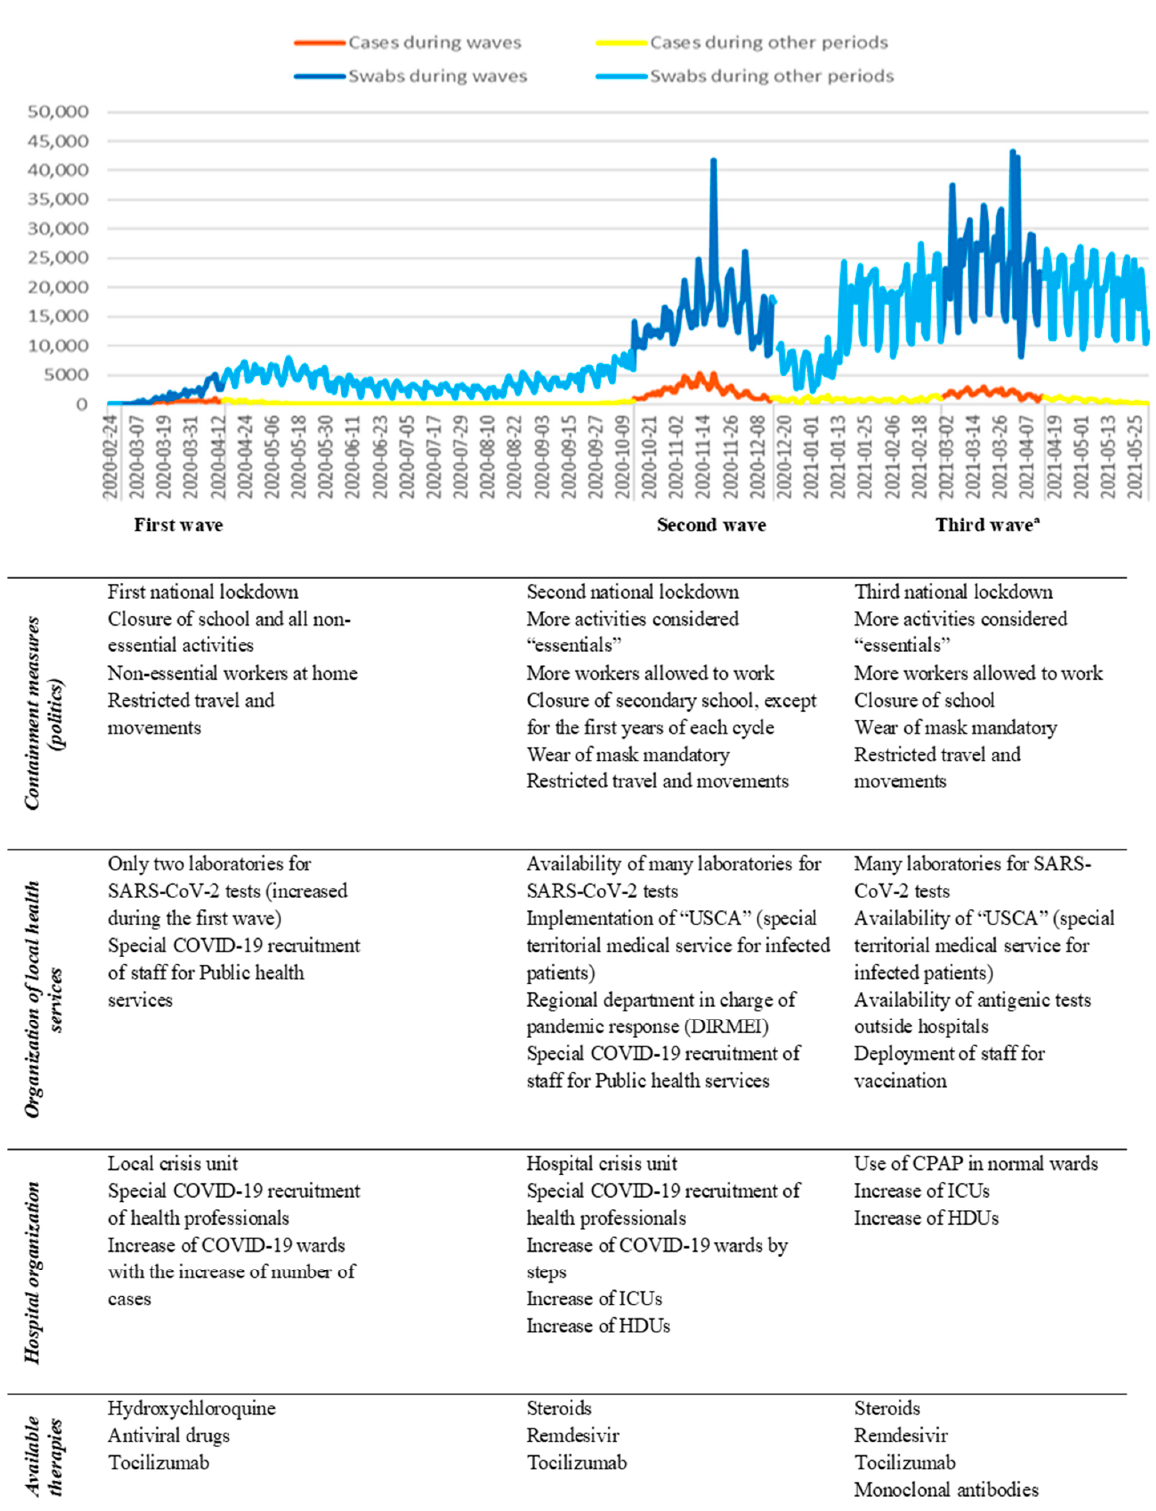
Figure 1. Number of swabs performed, number of new SARS-CoV-2 positive cases registered in Piedmont during the COVID-19 pandemic, and main interventions issued by the Italian Government and the health care system. (Data source: GitHub—pcm-dpc/COVID-19: COVID-19 Italia—Monitoraggio situazione). a Spread of Delta variant.